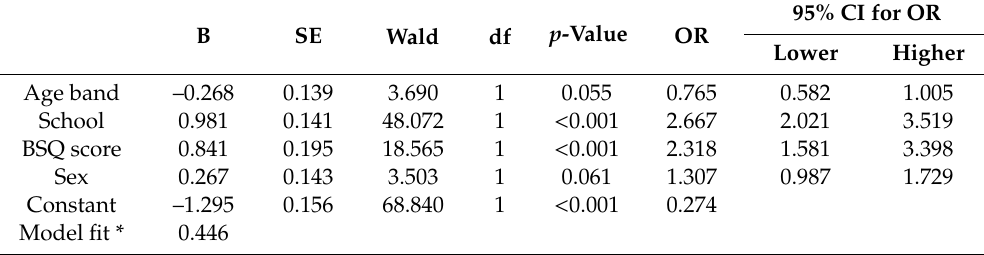
Table 3. Binary logistic regression model, with the response to low self-esteem in